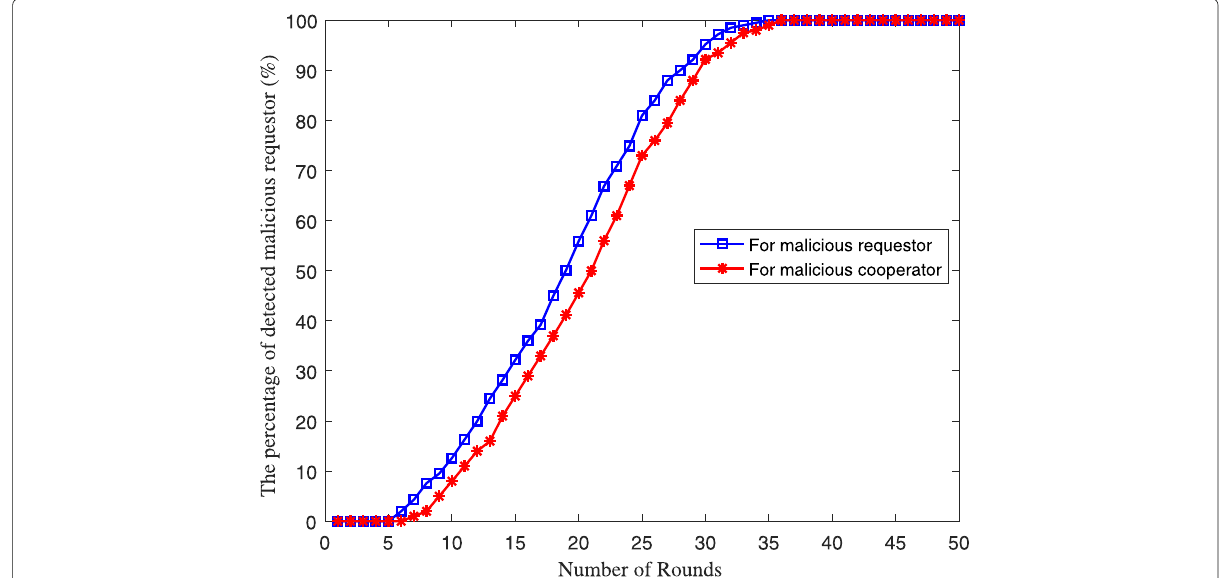
Fig. 9 The percent of case 1 detected malicious